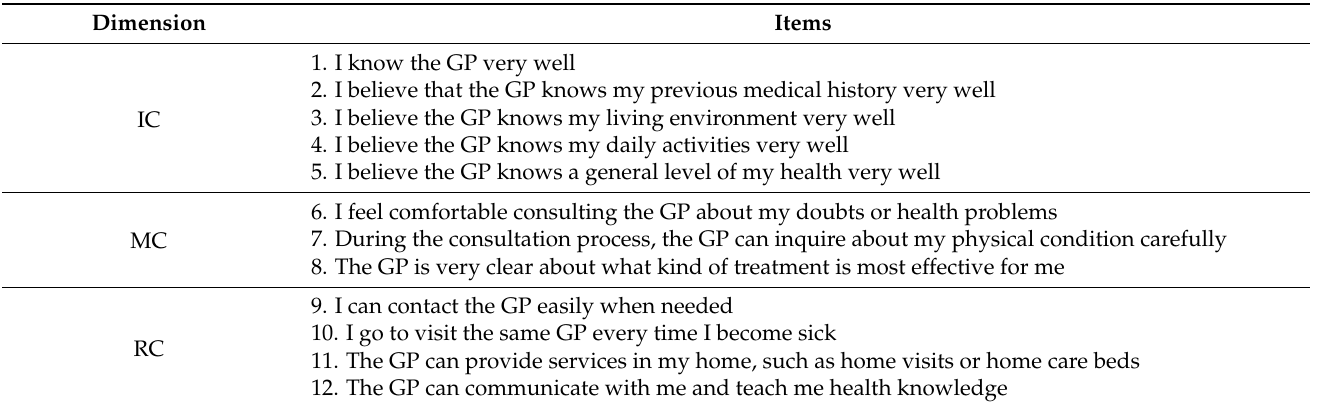
Table 1. Items for measuring continuity of GP